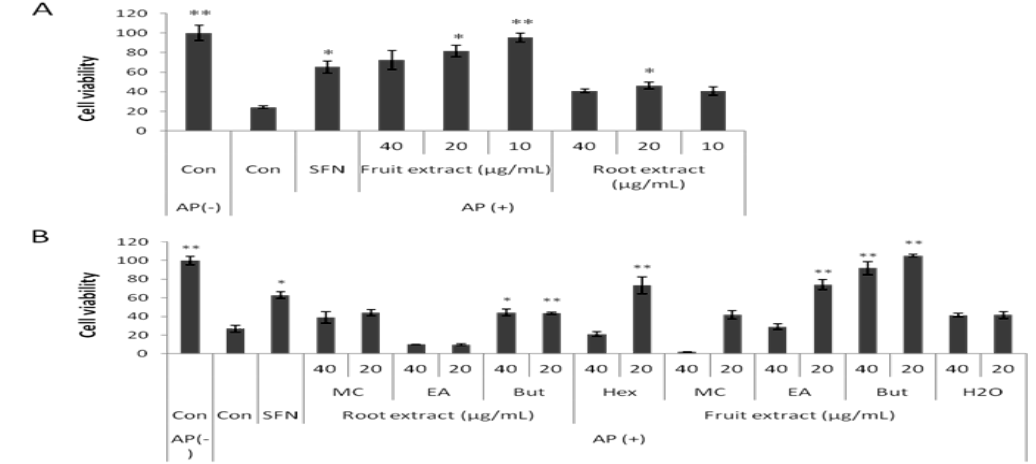
Fig. 1. Protective effect of the root and fruit extracts and fractions on cell viability. Each value represents the mean ±S.D. of three independent experiments with triplicate. Student’s t -test compared with AP treated group: * p < 0.005, ** p <